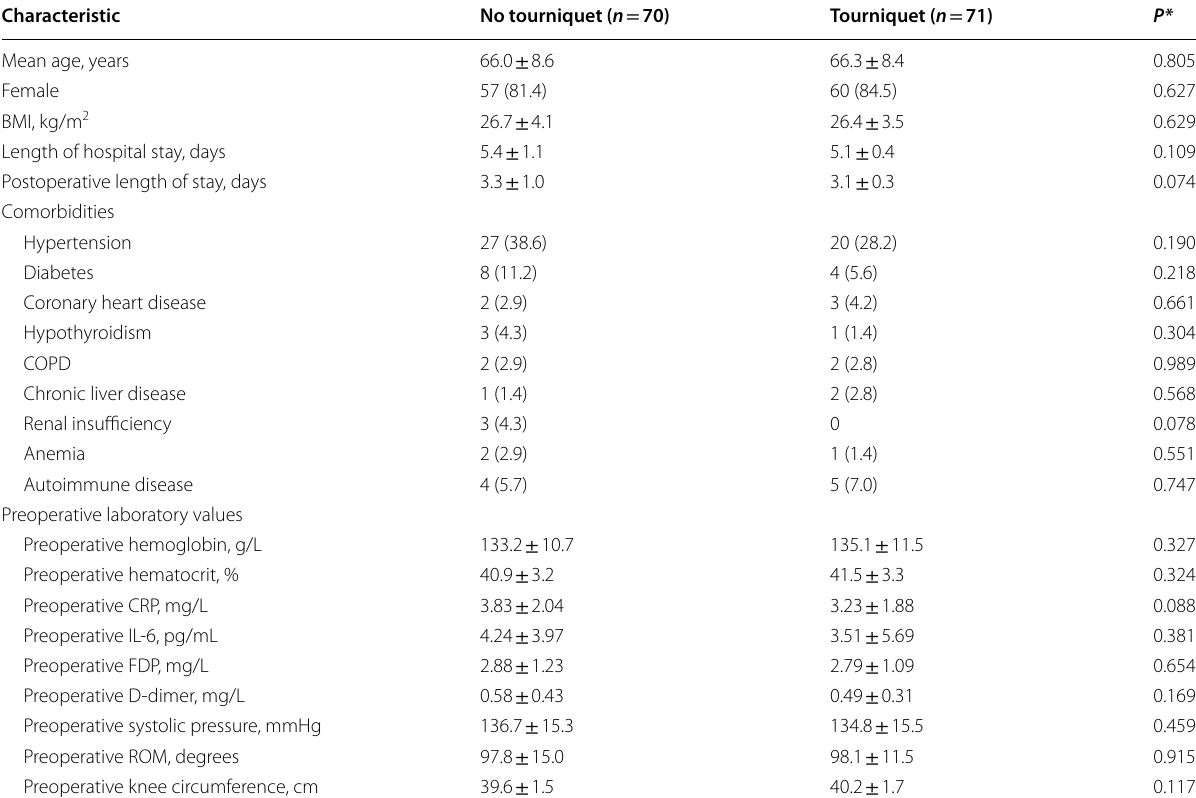
Table 1 Baseline characteristics of and comorbidities in patients undergoing TKA with or without a tourniquet